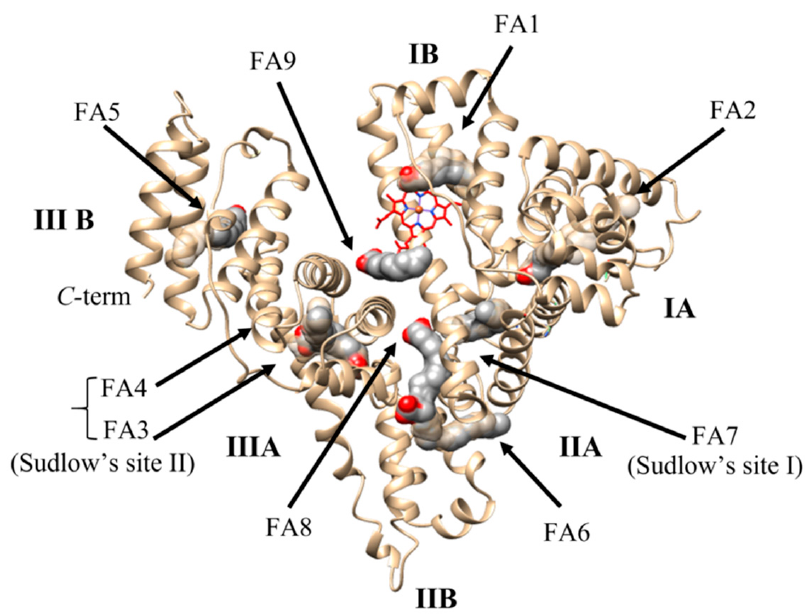
Figure 1. Three-dimensional structure of HSA (PDB ID: 1AO6) [40]. Fatty acids (FA) bound to specific sites are rendered as space-fill (gray). The heme is rendered as sticks (red). The picture has been drawn with UCSF-Chimera package [45].